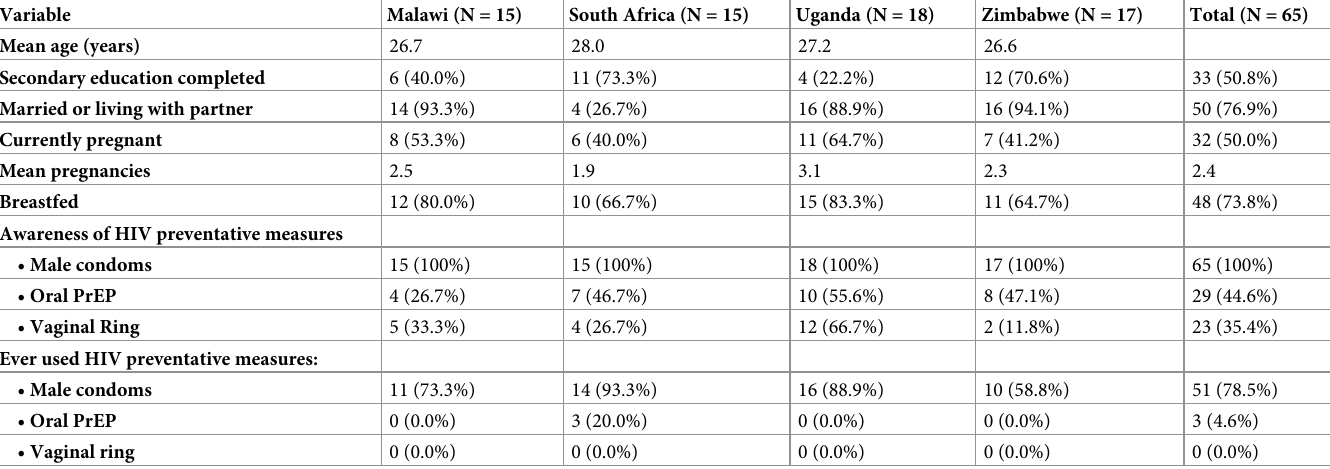
Table 2. Characteristics of sample by country and overall.